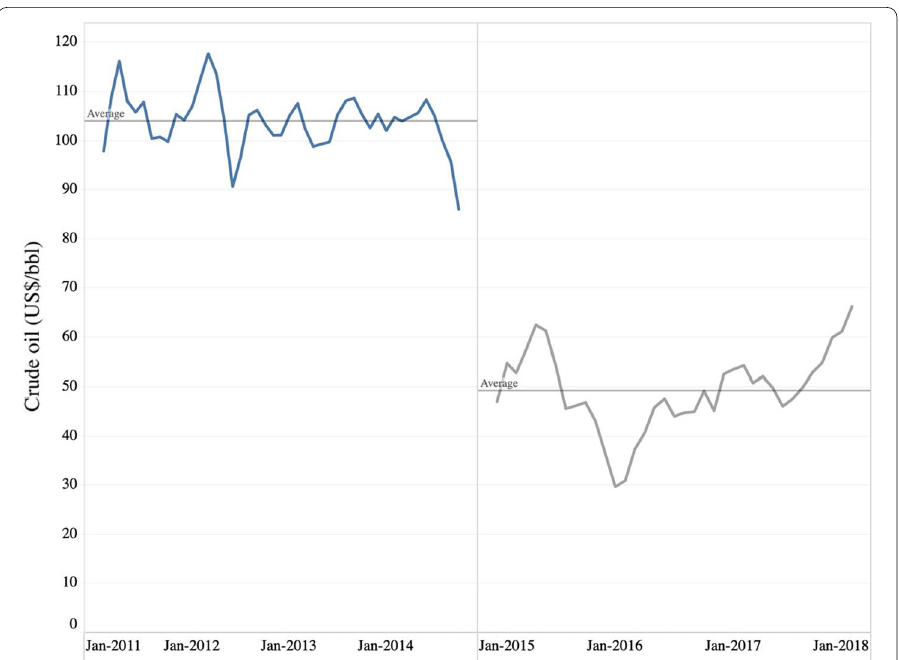
Fig. 2 Average monthly crude oil price in nominal US dollars from 2011 to 2018. Source : Authors’ estimate based on the average of Brent, Dubai, and WTI data provided by World